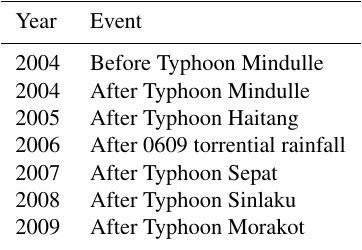
Table 1. List of landslide inventories generated in this